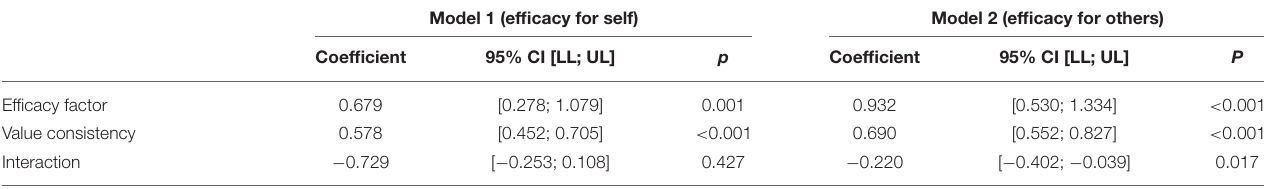
TABLE 3 | Moderation of the effect of the efficacy of the vaccine to protect the self (Model 1) or others (Model 2) by value consistency of vaccination.